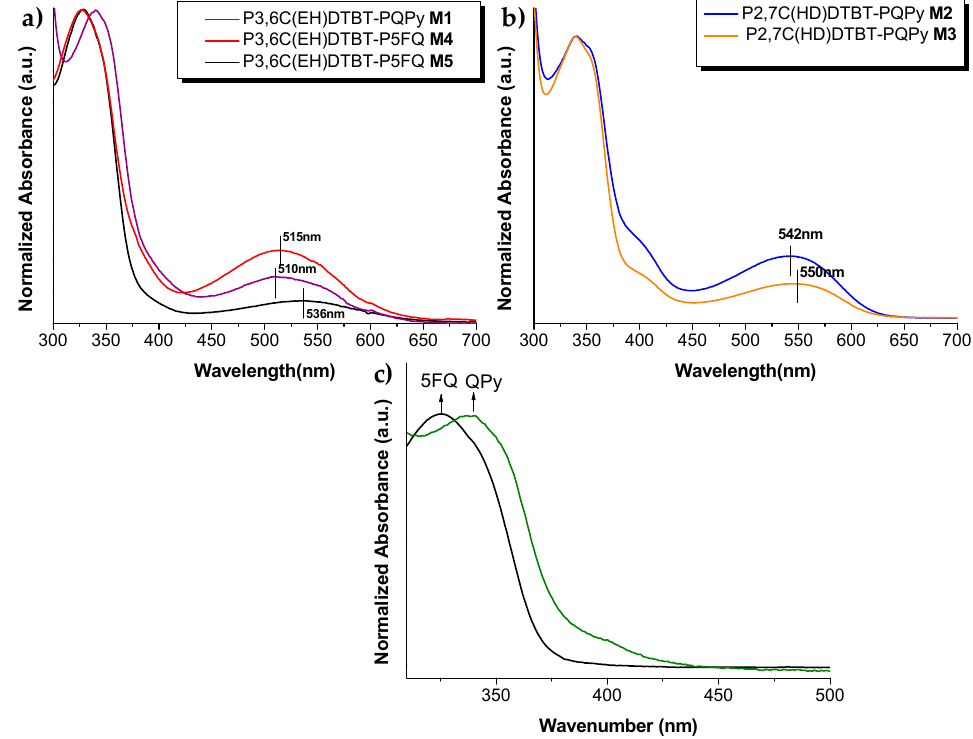
Figure 4. Normalized absorption spectra of ( a ) 3,6-carbazole-based copolymers M1, M4, M5 in o -DCB solutions and their maximum absorbance; ( b ) 2,7-carbazole-based copolymers M2, M3 in o -DCB solutions and their maximum absorbance; ( c ) absorption spectra of 6–vinylphenyl-(2- perfluorophenyl)–4–phenyl quinoline and 6-vinylphenyl-(2–pyridinyl)-4-phenyl-quionoline in o -DCB solutions.